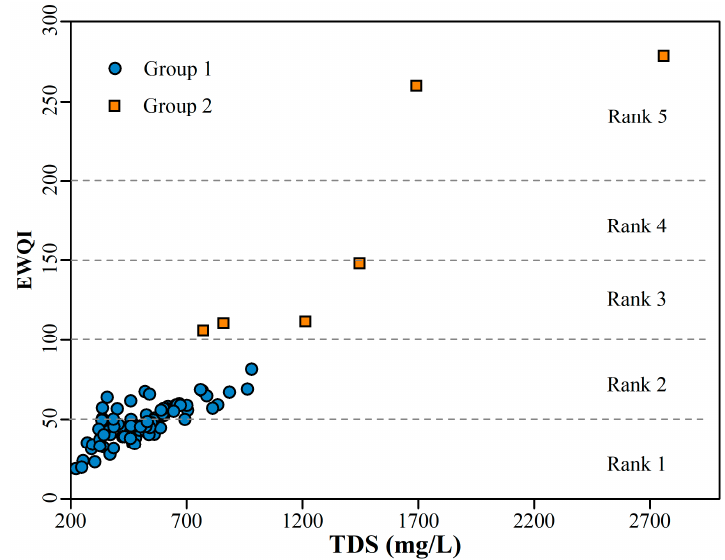
Figure 9. The relationship between the entropy-weighted water quality index (EWQI) and TDS.